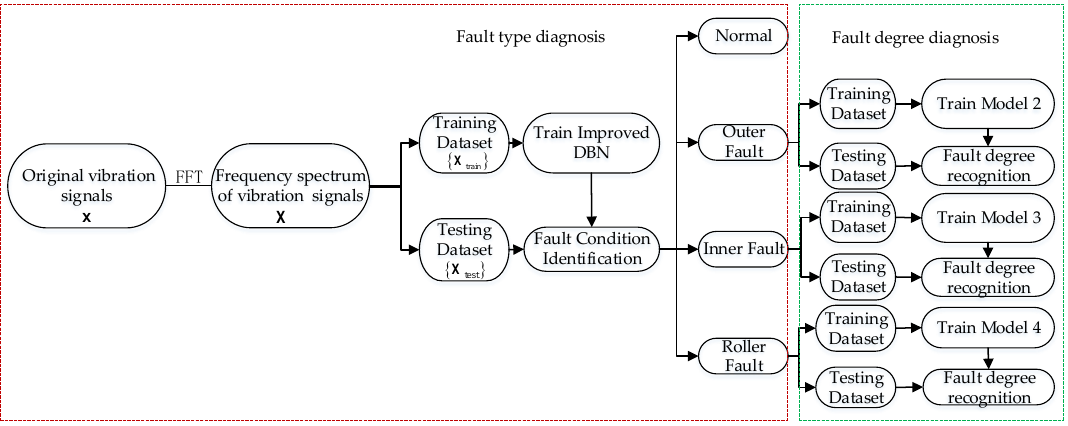
Figure 3. Flowchart of hierarchical fault diagnosis method.